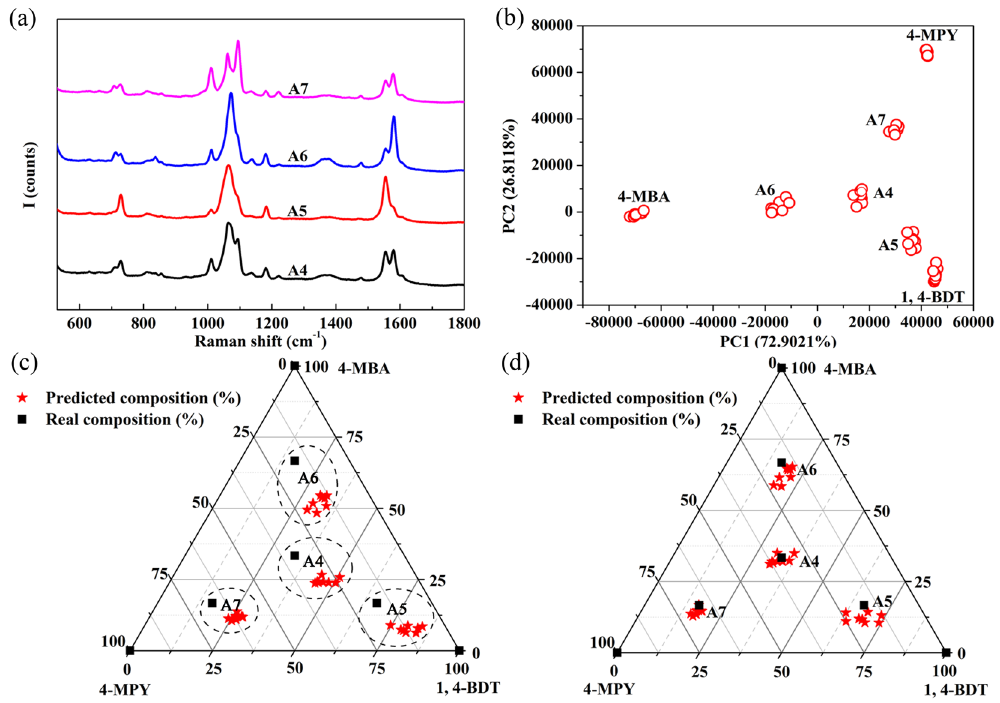
Figure 4. ( a ) SERS spectra of ternary mixture sample A4 to A7. ( b ) Plot of PCA scores for 1, 4-BDT, 4-MBA, 4-MPY, and their ternary mixture sample A4 to A7. ( c ) Plot of real composition in solution versus composition predicted by PCA. ( d ) Plot of real composition in solution versus composition of corrected PCA